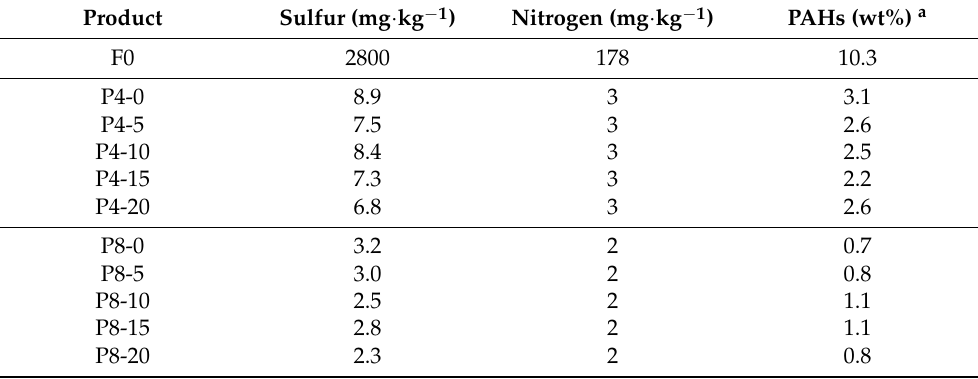
Table 4. Contents of the sulfur, nitrogen, and PAHs in the hydrotreating products.